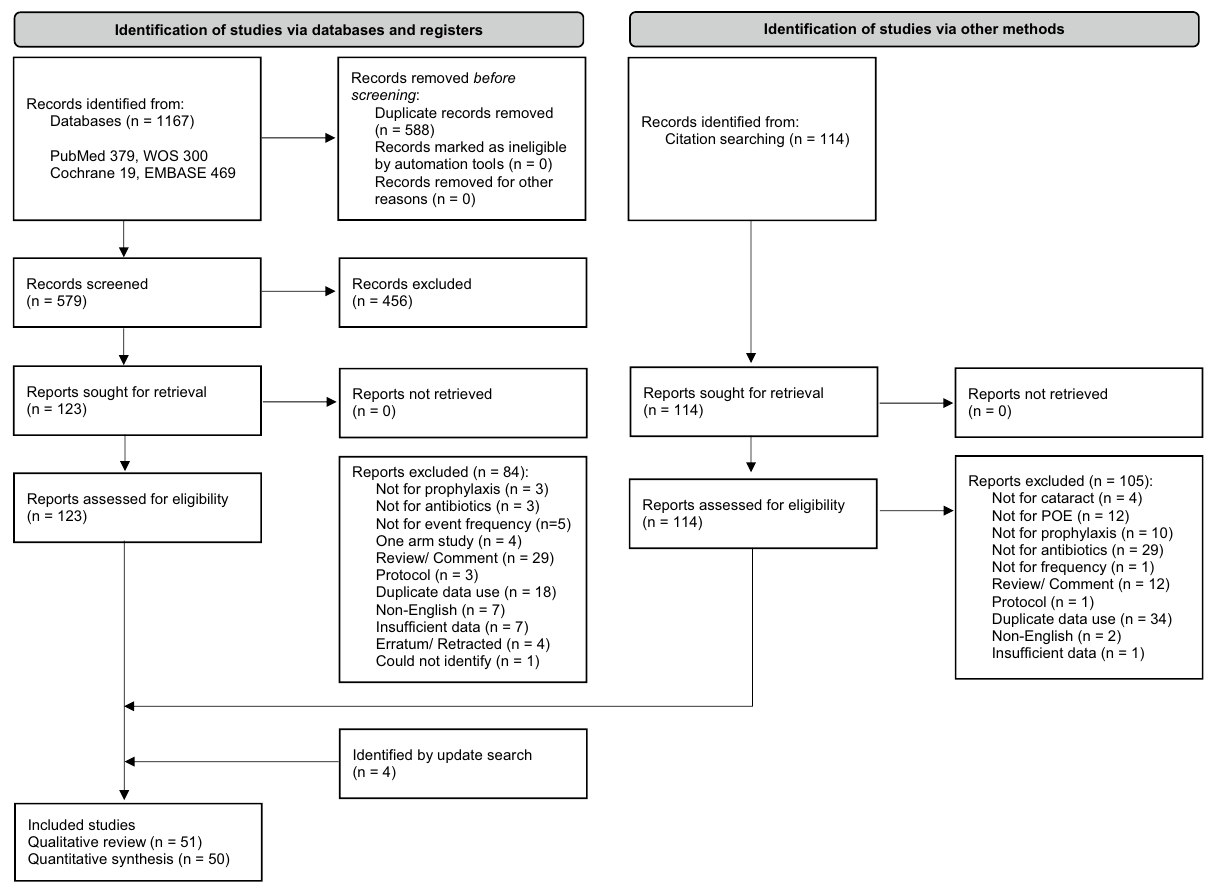
Figure 1. Preferred reporting items for systematic reviews and meta-analyses 2020 flow diagram. POE postoperative